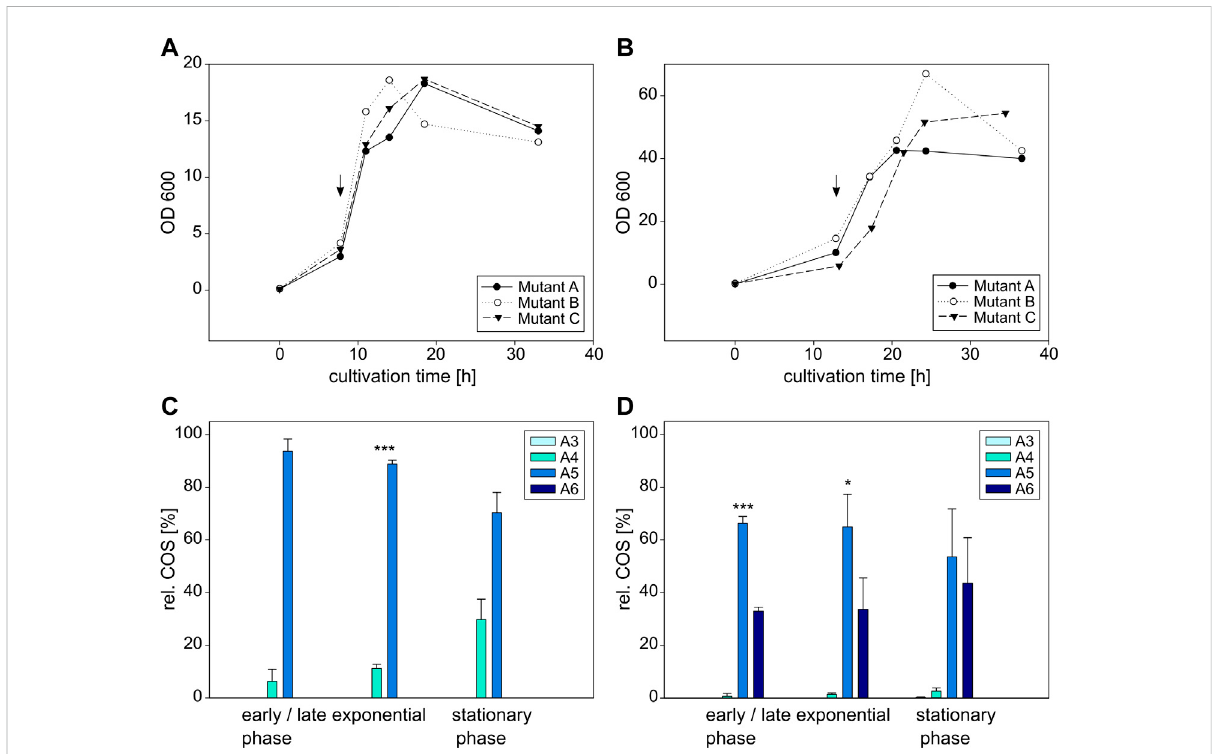
FIGURE 6 Cultivation and COS production of E coli BL21 (left) and C glutamicum (right) expressing the NodC_S19L mutein. Depicted is the growth of E. coli (A) and C. glutamicum (B) in triplicates as well as their product composition (C,D) . The time of induction is denoted with an arrow. MS signals were converted into molar fractions and are shown as shares of the total amount of product, namely the relative amount of fully acetylated trimer (A3) to hexamer (A6) for E. coli (C) and C. glutamicum (D) . The asterisks inC and D indicate thesigni fi cance level for the difference between